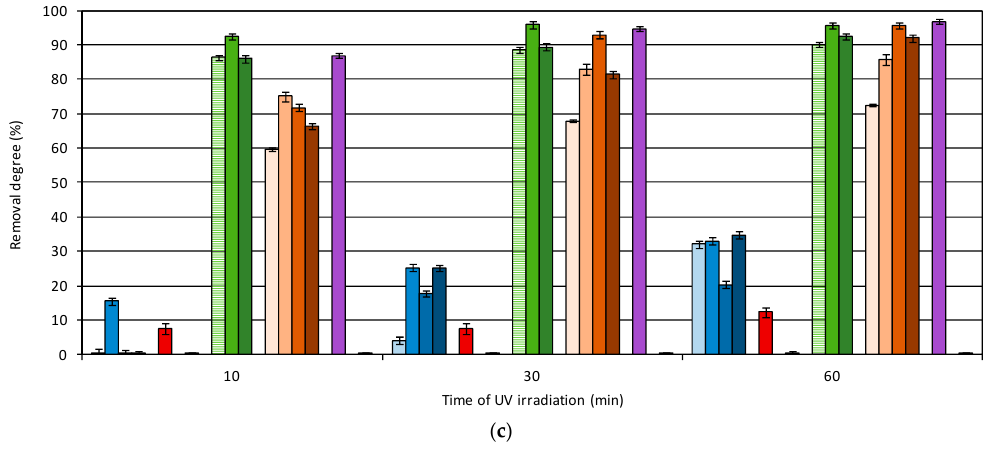
Figure 2. Degradation of micropollutants in the ( a ) H 2 O 2 , ( b ) O 3 and ( c ) UV processes.